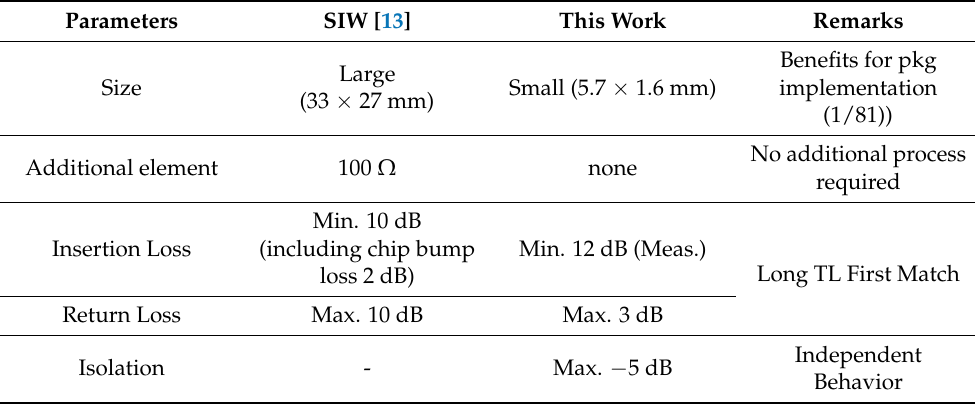
Table 1. Comparison of strengths and weaknesses.